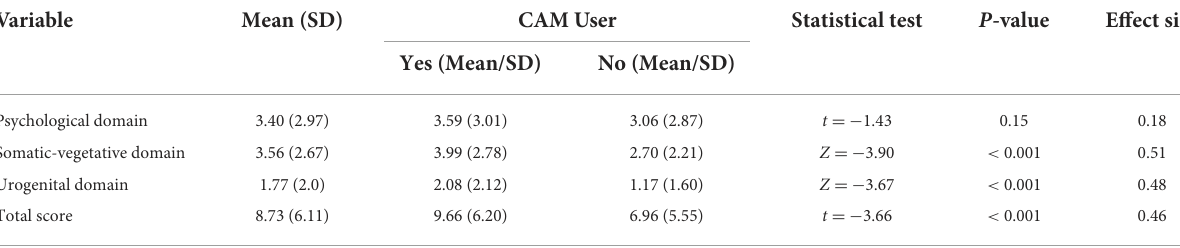
TABLE 2 Comparison of menopause symptoms in CAM users and non-users. Variable